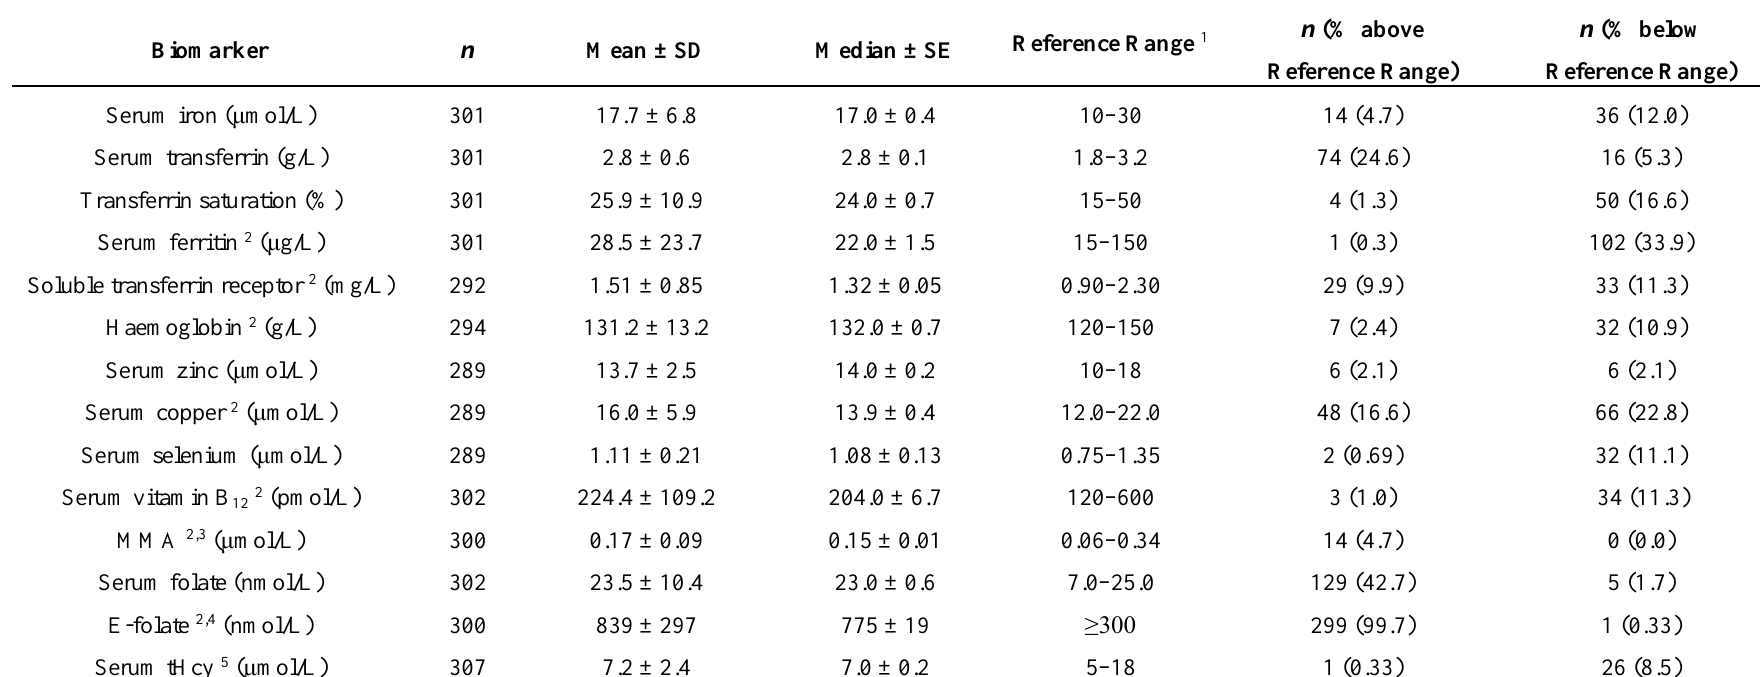
Table 1. Biomarkers of iron, zinc, selenium, copper, vitamin B 12 and folate statuses in young